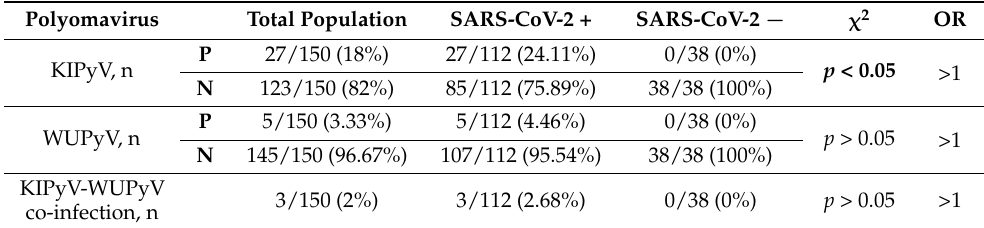
Table 2. Analysis of KIPyV and WUPyV prevalence in the examined population.